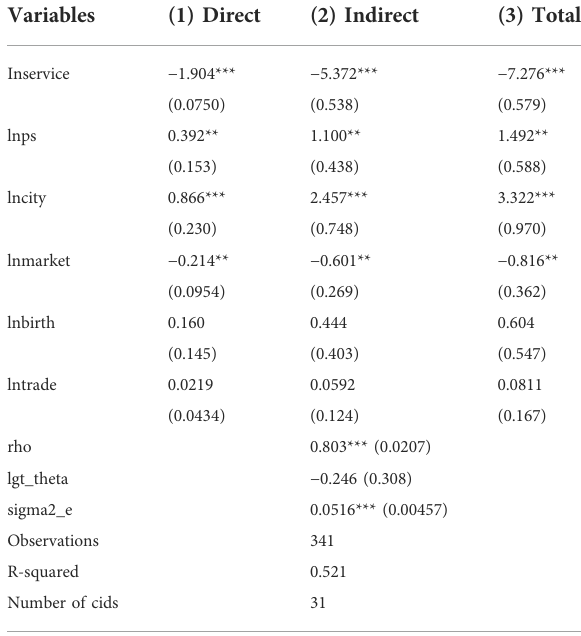
TABLE 3 Spatial econometric regression results of contributing